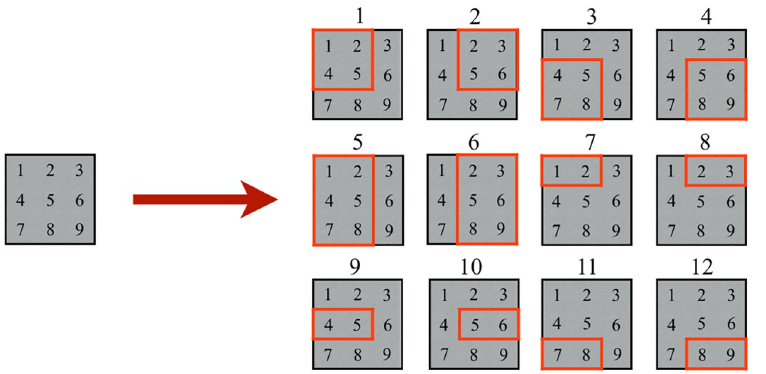
Fig 5. P&C without rotation. Set of valid positions when the 90˚ rotations are not allowed.